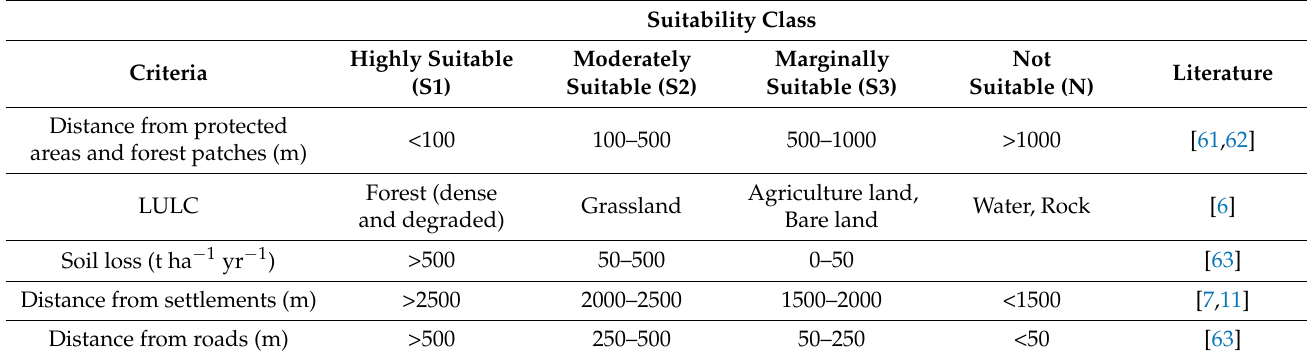
Table 4. Reclassification of the criteria for land suitability analysis (data source from: [1,23]). Suitability